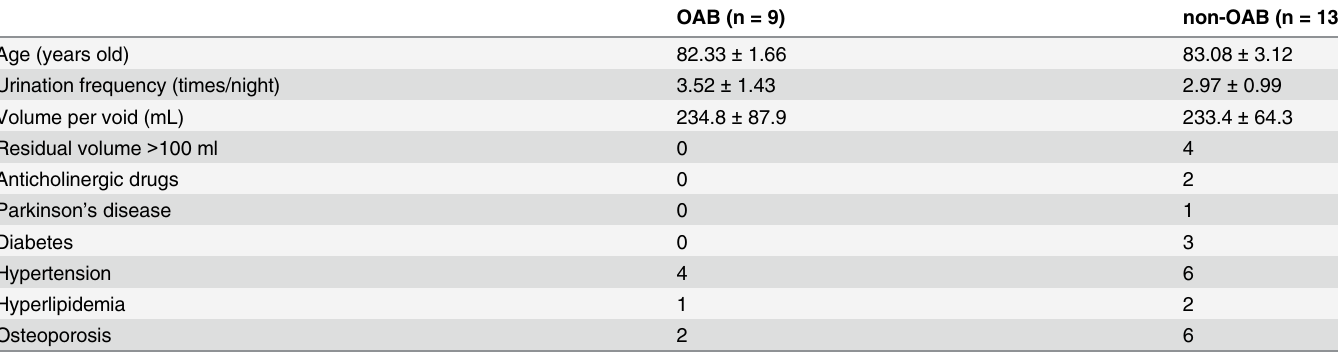
Data are expressed as mean ± standard deviation.